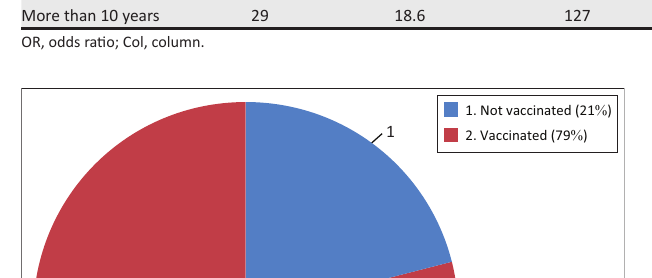
)1. Not vaccinated (21 % 1 2. Vaccinated (79 %